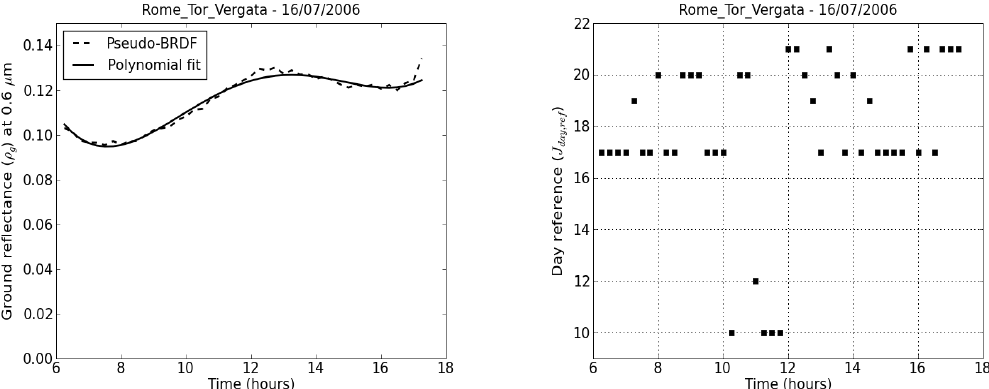
Fig. 1. Rome site on the 16 July 2006. Left panel: ground reflectance ( ρ g ) at 0.6µm: the subset of BRDF (or reference reflectance) based on the 14 days minimum (black dashed curve) and the fourth degree polynomial fit (black curve). Right panel: J day , ref : the day with the smallest L1B reflectance at VIS06 channel.